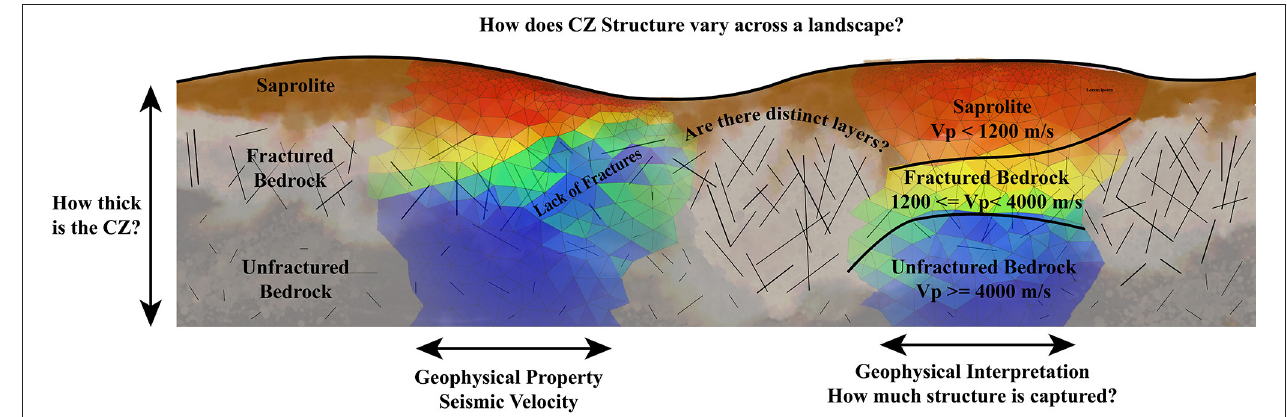
FIGURE 1 | Conceptual drawing of the CZ showing how complexity translates into the smooth velocity images produced with seismic refraction. In CZ studies we represent the complex CZ as discrete elements of a specific physical property—in this case seismic velocity. This figure highlights the challenge of representing complex CZ structure as velocity profiles. A key to utilizing seismic refraction in CZ studies is understanding the scale over which seismic refraction velocities are